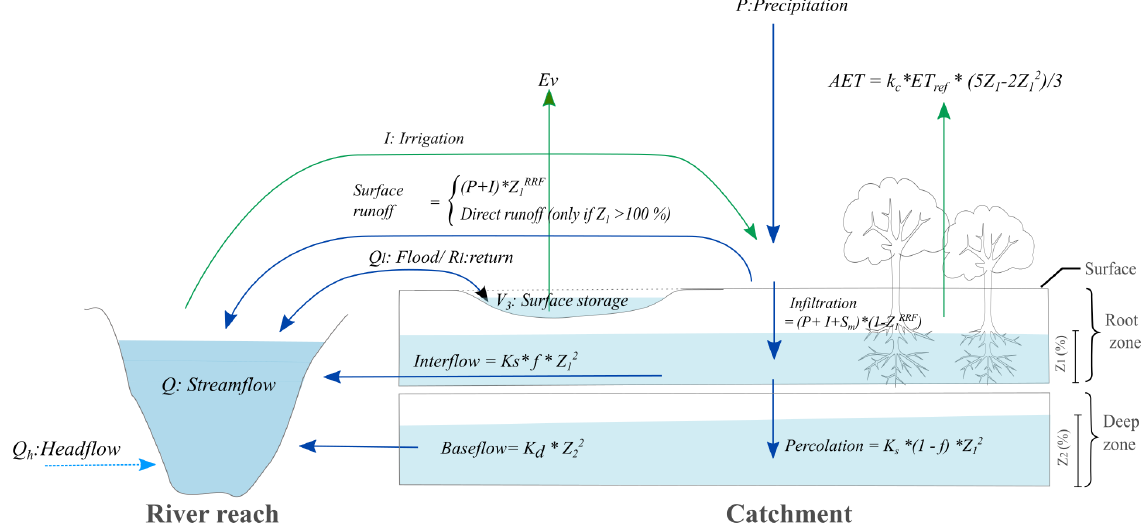
Figure 4. Schematic of the enhanced two-layer soil moisture model including a surface storage component.